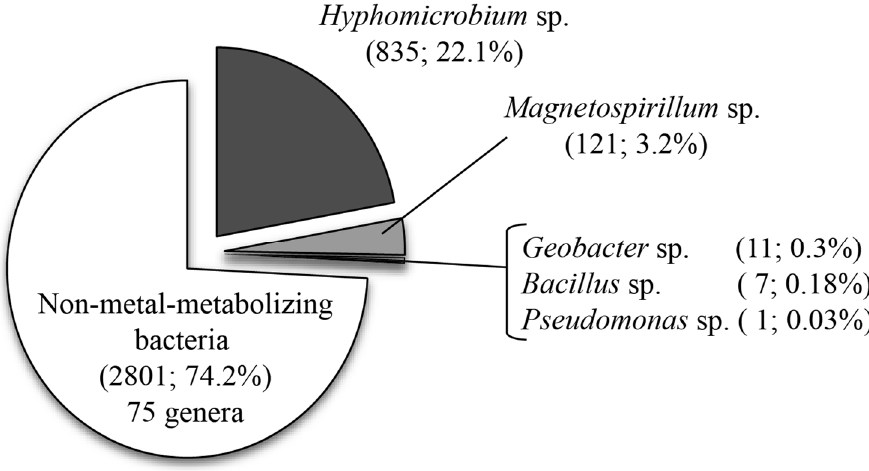
Figure 2. Bacterial community structure in the Mn-deposit collected from the metal refinery wastewater pipe. Values in brackets indicate the total number of sequences and the percentage.